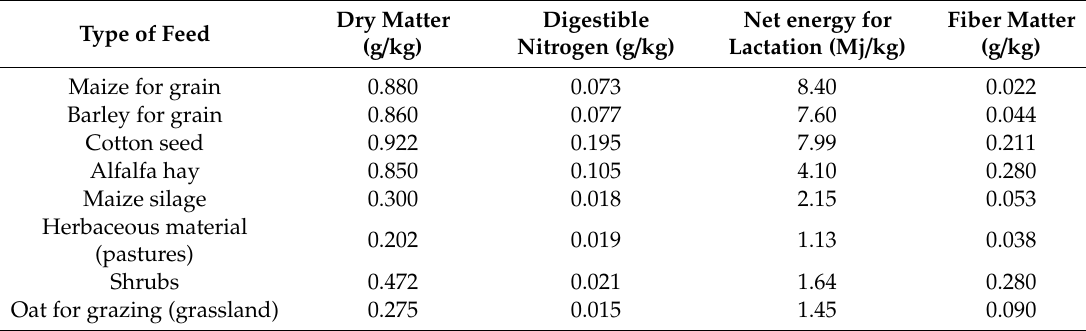
Table 2. Nutritional value of